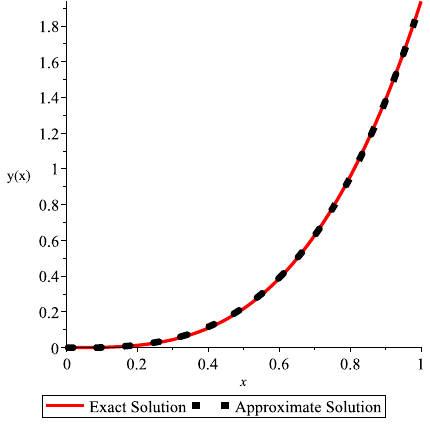
Figure 1. Comparison of approximate solution and exact solution for Example